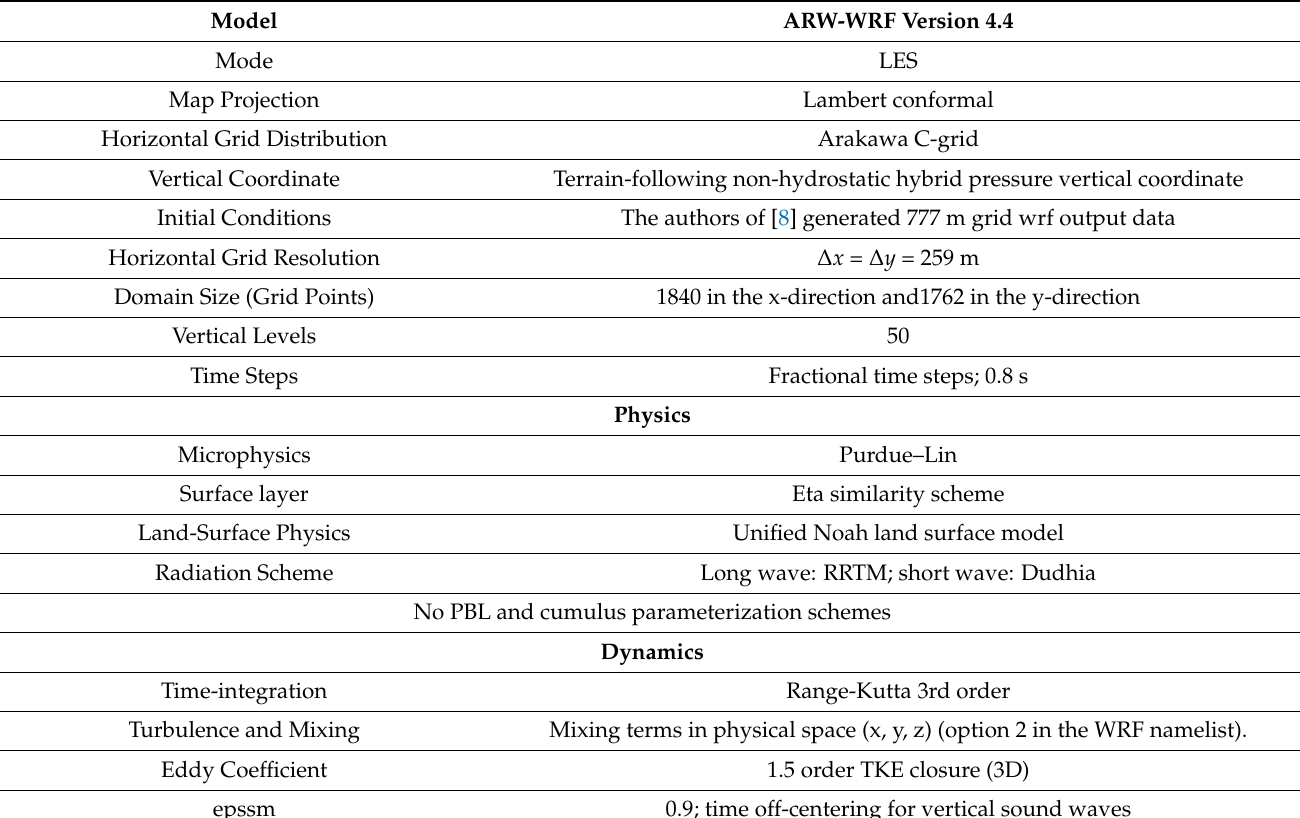
Table 1. Summary of the WRF-LES model